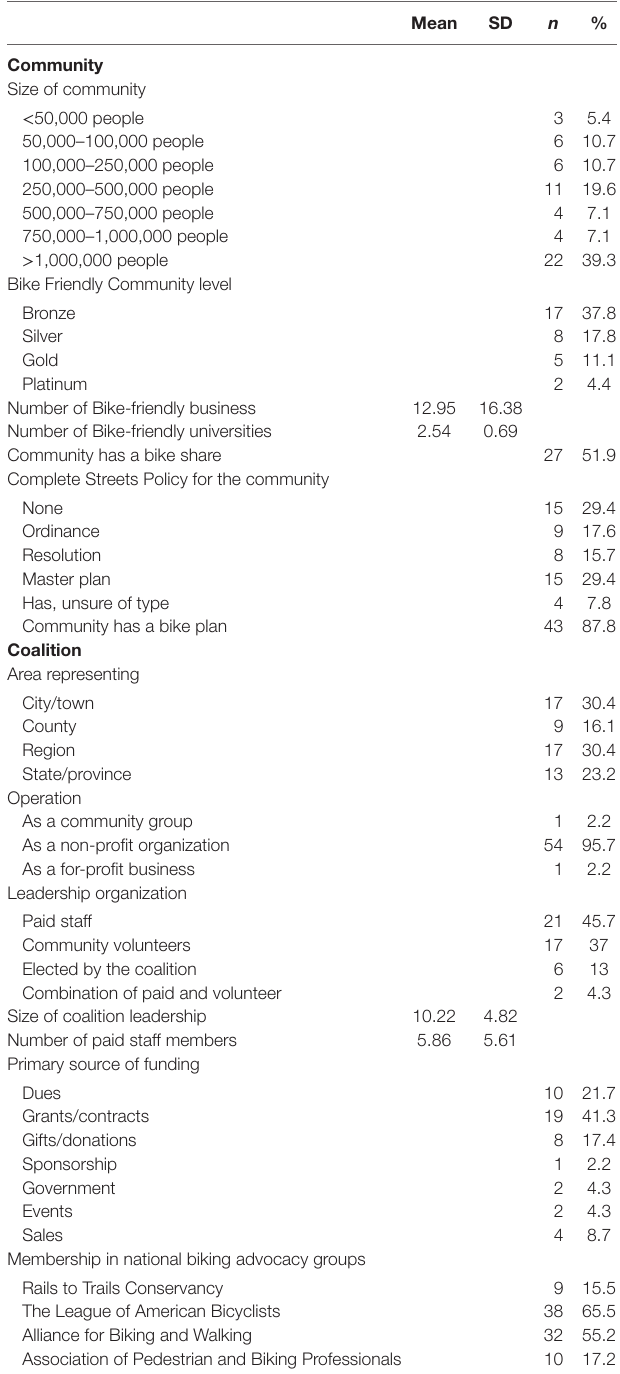
TaBle 1 | Description of the sample ( n =